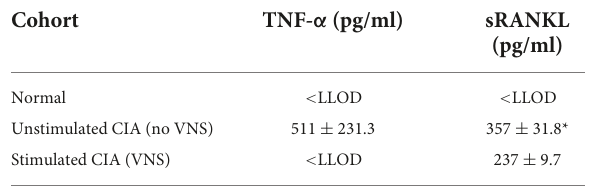
TABLE 2 Effect of vagus nerve stimulation on tumor necrosis factor-alpha (TNF- α ) and soluble receptor activator of NF κ B ligand (sRANKL) levels at 17 days following collagen